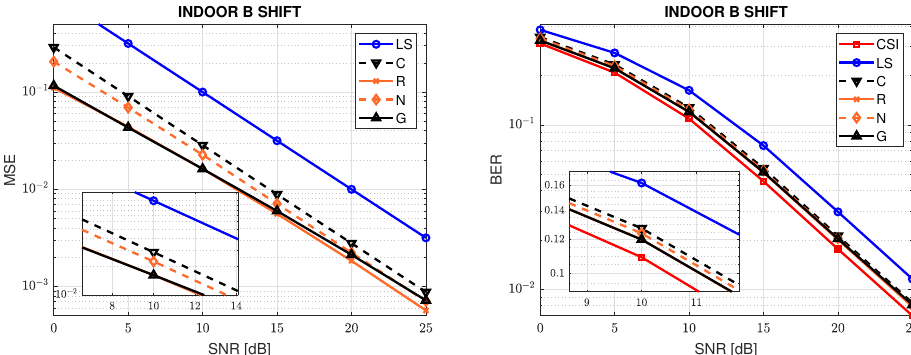
Figure 6. MSE and BER measures for modified Indoor B channel